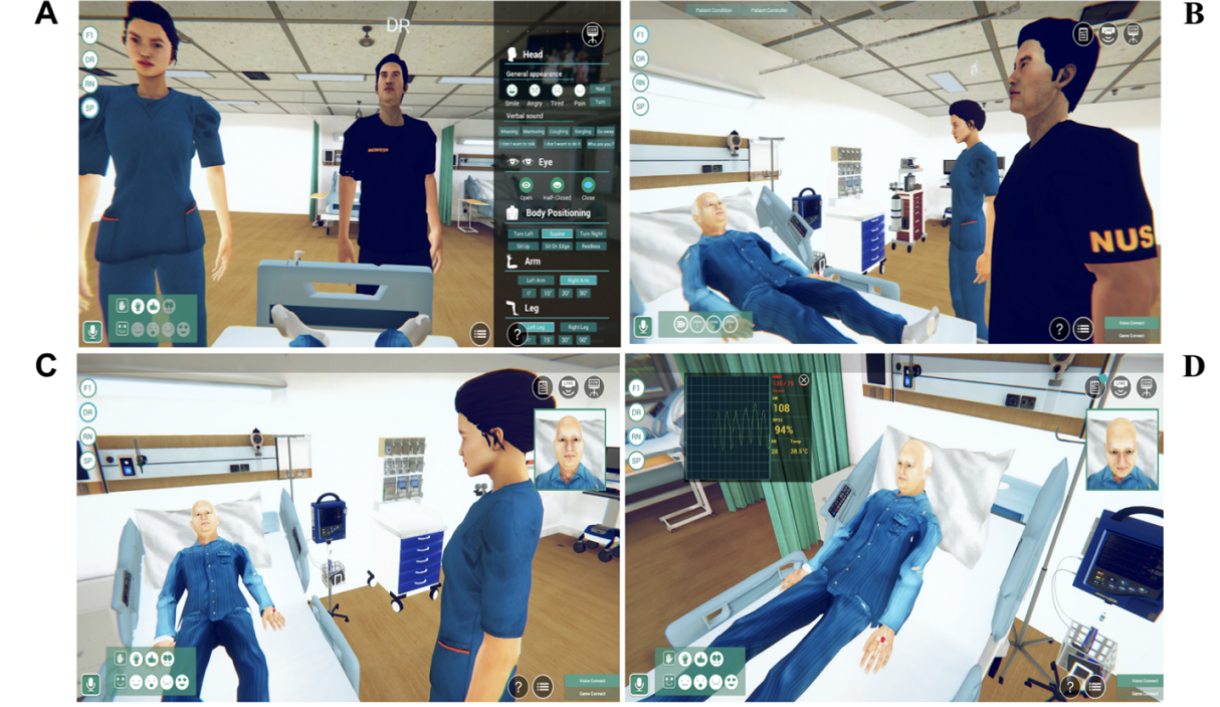
Figure 1. Viewpoints of different users. A: simulated patient’s view; B: facilitator’s view; C: medical student’s view; D: nursing student’s